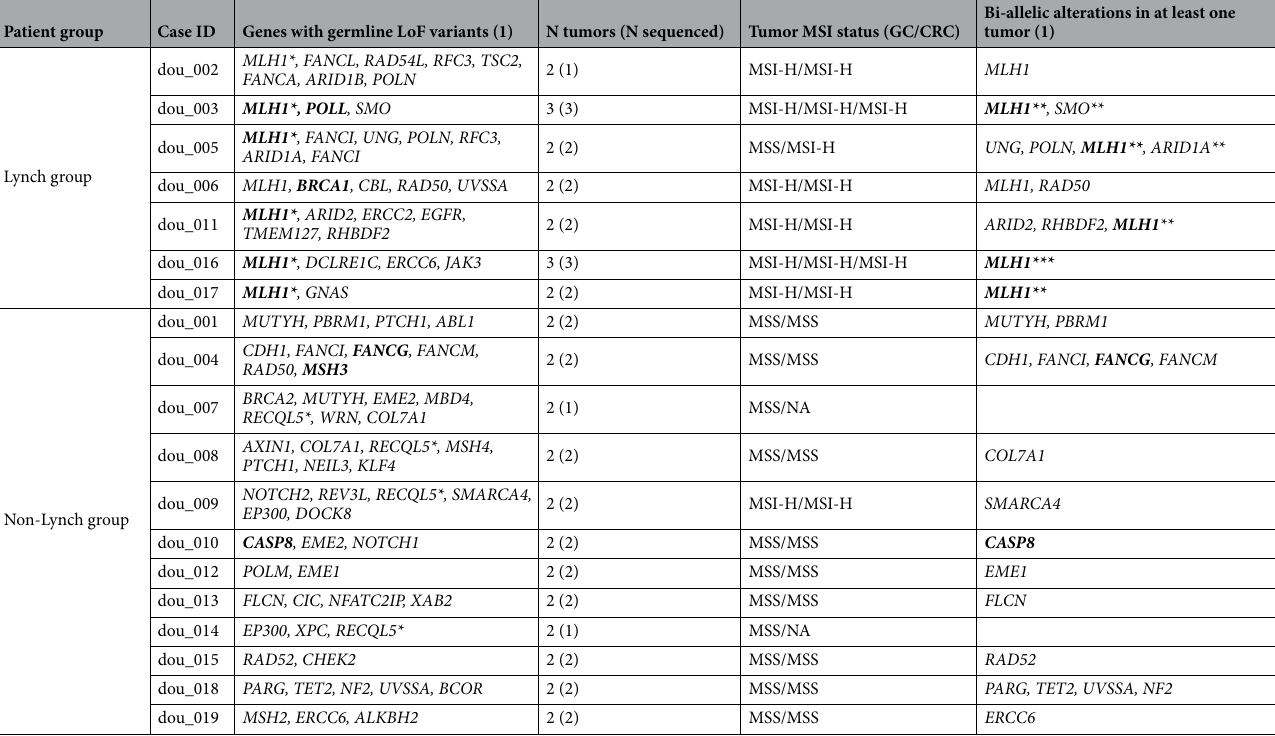
Table 3. Summary of candidate loss-of-function germline candidate genes and the status of loss of heterozygocity of corresponding tumors. (1) High confidence LoF prediction in bold. *Significantly recurrent in eoMPC. **Bi-allelic alteration was observed in 2 tumors. ***Bi-allelic alteration was observed in 3